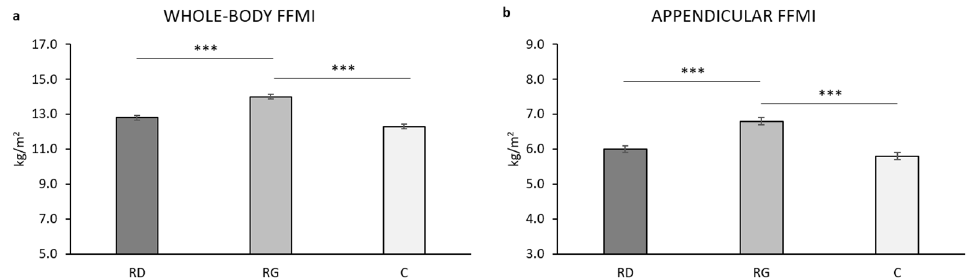
Figure 3. Estimated marginal means for fat-free mass index (FFMI, kg/squared stature in meters) at whole body (panel a ) and appendicular (panel b ) level in the three groups of girls after adjusting for age, body mass, and menarche. RD, recreational dancers; RG, recreational gymnasts; C, physically active controls. ***, p ≤ 0.001.